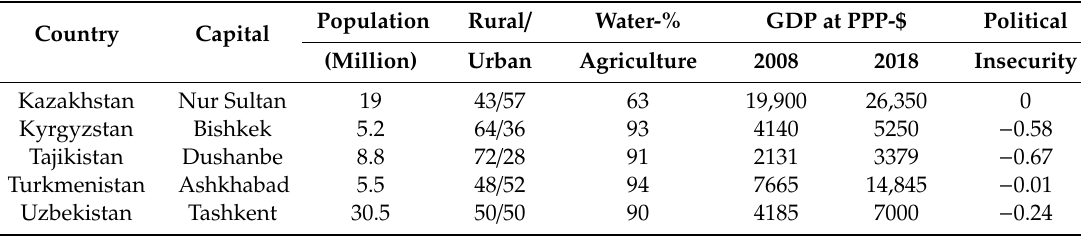
Table 1. Social dynamics in Central Asia. Political insecurity—a positive number reflects higher state stability [23–25]. Population Rural / Water-% GDP at PPP-$ Political Country Capital